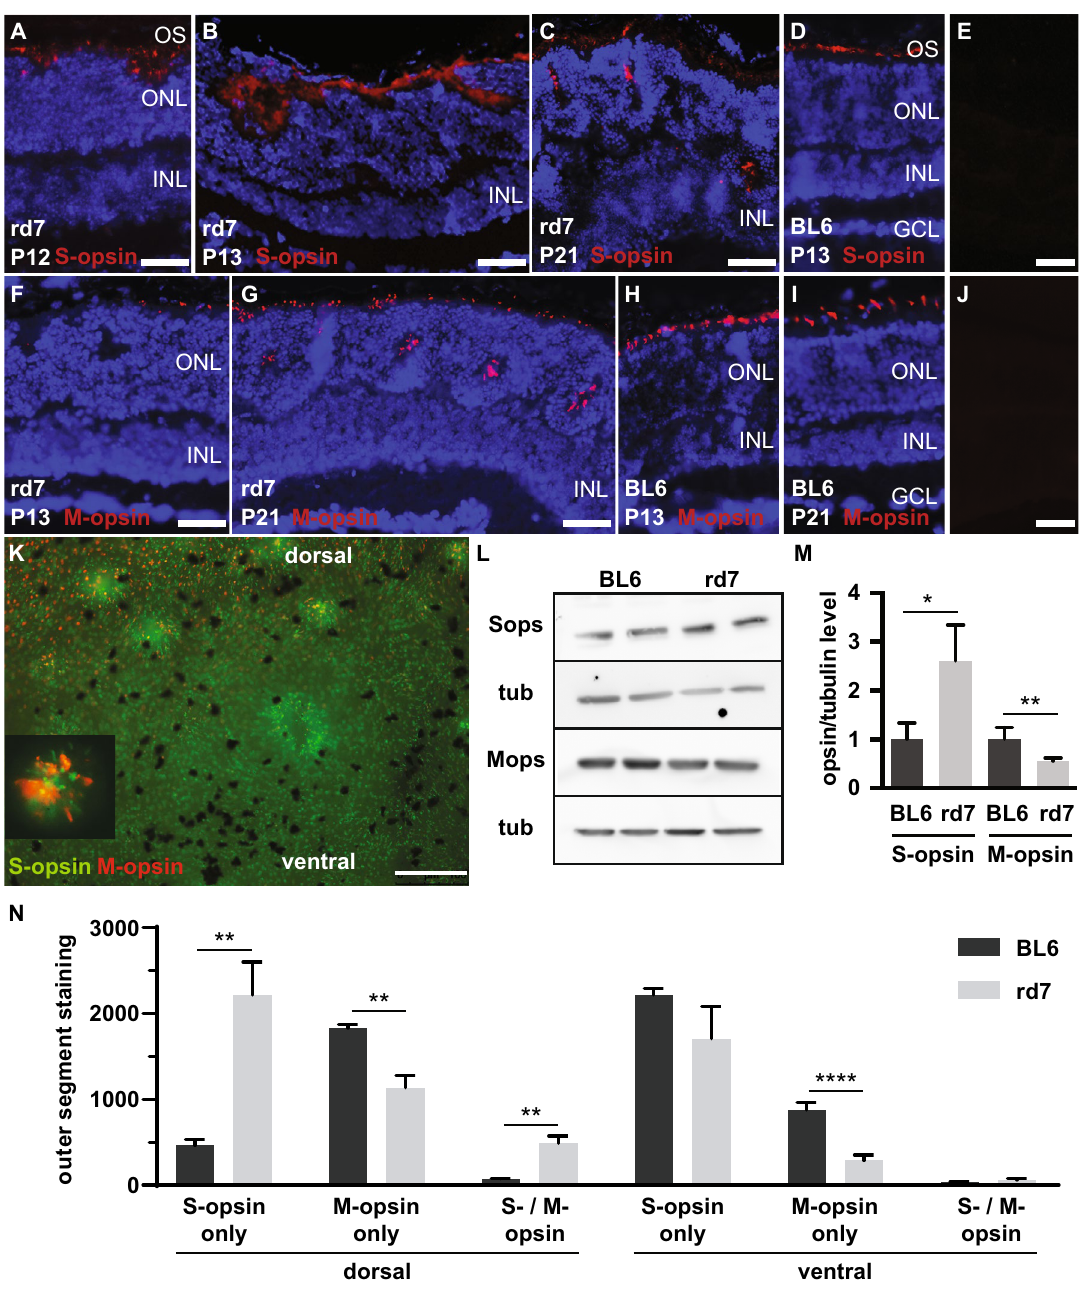
Figure 7. S- and M-opsin expression and distribution in early postnatal C57BL/6J Nr2e3 rd7/rd7 retinas. S-opsin staining on C57BL/6J Nr2e3 rd7/rd7 (rd7) retinas at P12 ( A ), P13 ( B ), P21 ( C ), and, C57BL/6J (BL6) retinas at P13 ( D ). M-opsin staining on C57BL/6J Nr2e3 rd7/rd7 retinas at P13 ( F ) and P21 ( G ) and, C57BL/6J retinas at P13 ( H ) and P21 ( I ). All sections are counterstained with DAPI for visualization of nuclei. Negative controls with secondary antibody only for S-opsin ( E ) and M-opsin ( J ) on C57BL/6J retinas at P21. OS: photoreceptor outer segments; ONL: outer nuclear layer; INL: inner nuclear layer; GCL: ganglion cell layer. Scale bars: 25 µM. ( K ) Flat mounts of C57BL/6J Nr2e3 rd7/rd7 retinas at P21 with co-detection of S-opsin (green) and M-opsin (red) protein expression in a central equatorial region adjacent to the optic disk. The insert shows a detailed view of rosettes containing S-opsin and M-opsin expressing cones. Scale bar: 100 µM. ( L ) Representative western blot of S-opsin (Sops: 39 kDa) and M-opsin (Mops: 40 kDa) expression in C57BL/6J (BL6) and C57BL/6J Nr2e3 rd7/rd7 (rd7) retinas at P21. Expression of α-tubulin (tub: 49 kDa) was assessed as loading control. ( M ) Quantification of 4 independent samples ± SD assessed by Western blot to determine relative S- and M-opsin protein levels in C57BL/6J (black bars) and C57BL/6J Nr2e3 rd7/rd7 (grey bars) retinas at P21. Statistical analysis was performed by unpaired t-test. *p < 0.05; **p < 0.01. ( N ) Quantification of cone outer segment staining for S- and M-opsin on C57BL/6J (BL6) and C57BL/6J Nr2e3 rd7/rd7 (rd7) retinal flat mounts at P21. Three dorsal and ventral regions each were analyzed on three flat mounts of C57BL/6J retinas (n = 3) and of seven flat mounts of C57BL/6J Nr2e3 rd7/rd7 retinas (n = 4). In C57BL/6J Nr2e3 rd7/rd7 only regions devoid of ‘rosettes’ were analyzed. Quantifications are reported ± SEM. Statistical analysis was performed by multiple unpaired t-tests. **p < 0.01; ****p <